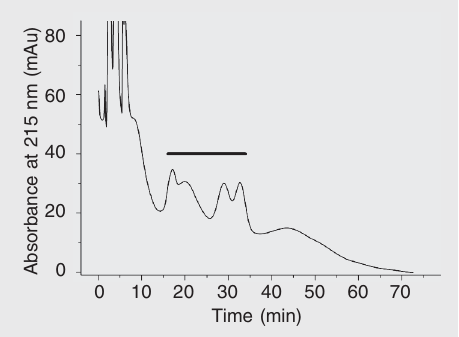
Figure 7. HPLC chromatogram of Passiflora quadrangularis hemolysin. HPLC conditions: C18Waters column, 3.8 mm in- ternal diameter x 300 mm, 15-20 µm operated at room tempera- ture (22 º C) with a mobile phase of CH 3 OH/H 2 O = 50/50 at a flow rate of 1 ml/min. The effluent was monitored at 215 nm using an AKTA ™ chromatography system (GE-Amersham Biosciences, Piscataway, NJ, USA). The ap- proximate elution position of the hemolysin is indicated by the solid horizontal line.